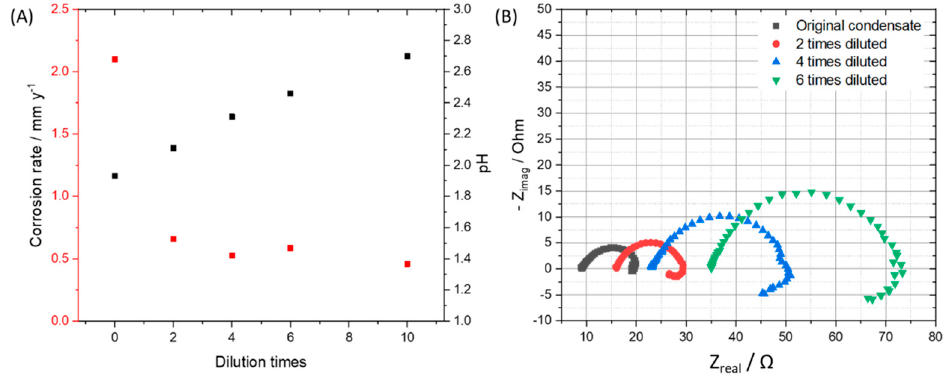
Figure 5. ( A ) Corrosion rates of the 7-day-exposing L360NB coupons in original, 2, 4, 6, and 10 times diluted condensates and pH of these CO 2 saturated condensates at the beginning of the test. ( B ) EIS spectra of 24 h exposed coupons in original and diluted condensates. Original condensate contains 0.114 M H 2 SO 4 and 0.0184 M HNO 3 .